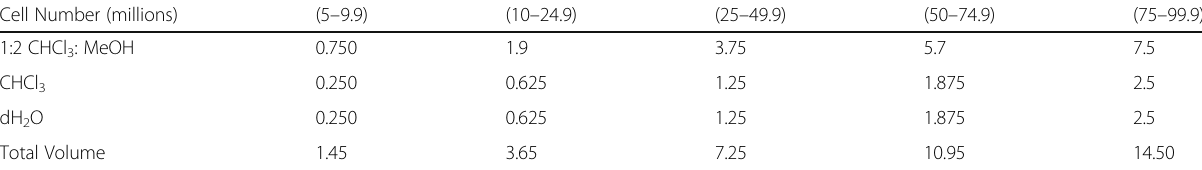
Table 1 Modified chart of the Dyer and Bligh lipid extraction method Cell Number